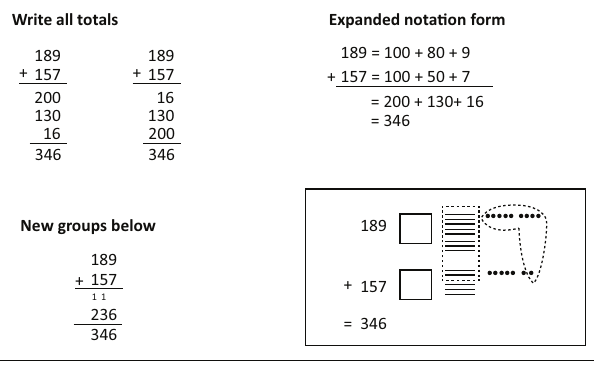
FIGURE 5: Mathematics drawing and variations on SWA.